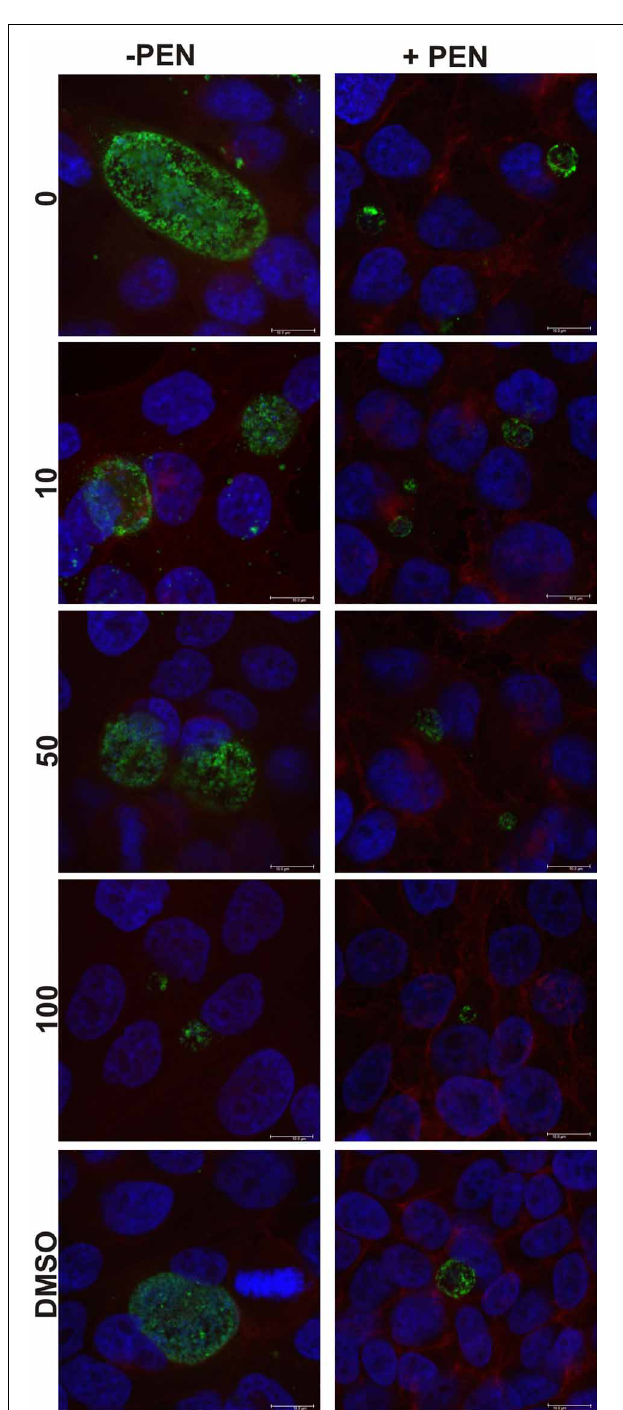
FIGURE 5 | Confocal microscopy images of C. trachomatis cultures at 68h PI, or 38h after penicillin reversion commenced. Cultures were treated with penicillin 100U ml − 1 (right column) at 4h PI, and with JO146 at 16h PI (concentrations indicated by the gray shading, legend to right of each graph). Penicillin was removed from the cultures at 30h PI. The image colors are as follows, green: MOMP (major outer membrane protein) is green, blue: cell nucleus (DAPI), and red indicates β -actin. Scale bar (bottom right) indicates 10 μ